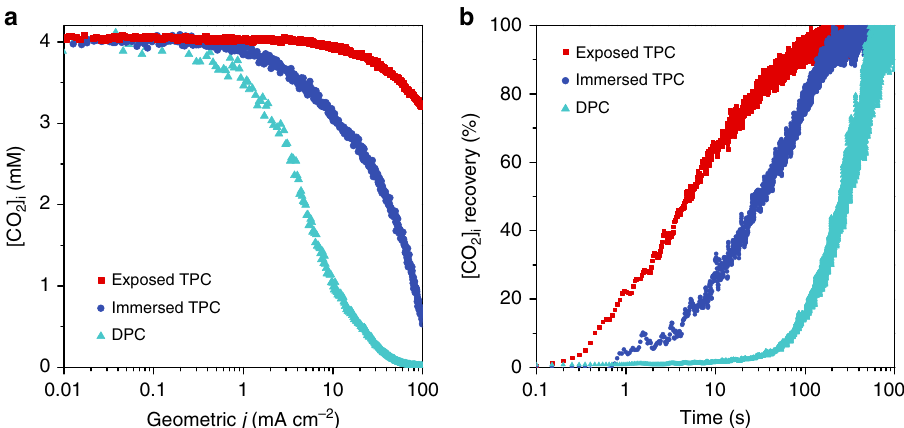
Fig. 5 Effect of CO 2 transportation on electrochemical CO 2 RR. a [CO 2 ] i versus geometric current density showing the best CO 2 concentration stability is achieved in the exposed TPC system, especially at high current densities. b Time-dependent [CO 2 ] i recovery after stopping electrolysis. Source data are provided as a Source data